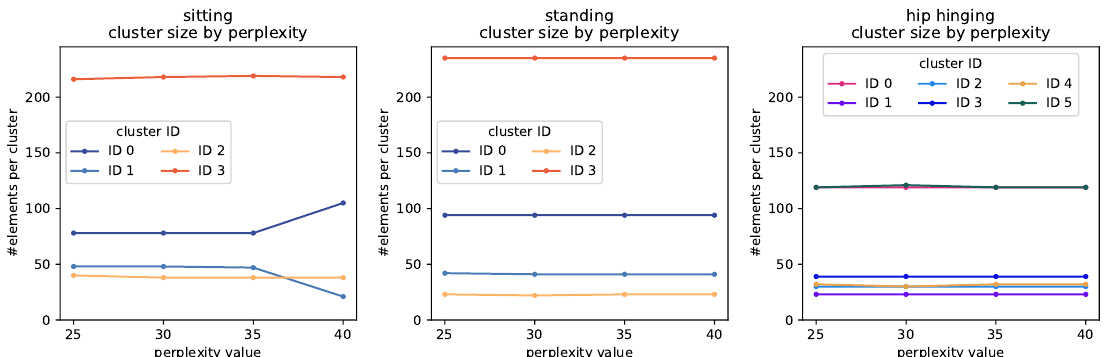
Figure 5. The number of elements per cluster under variation of the perplexity value, plotted by cluster